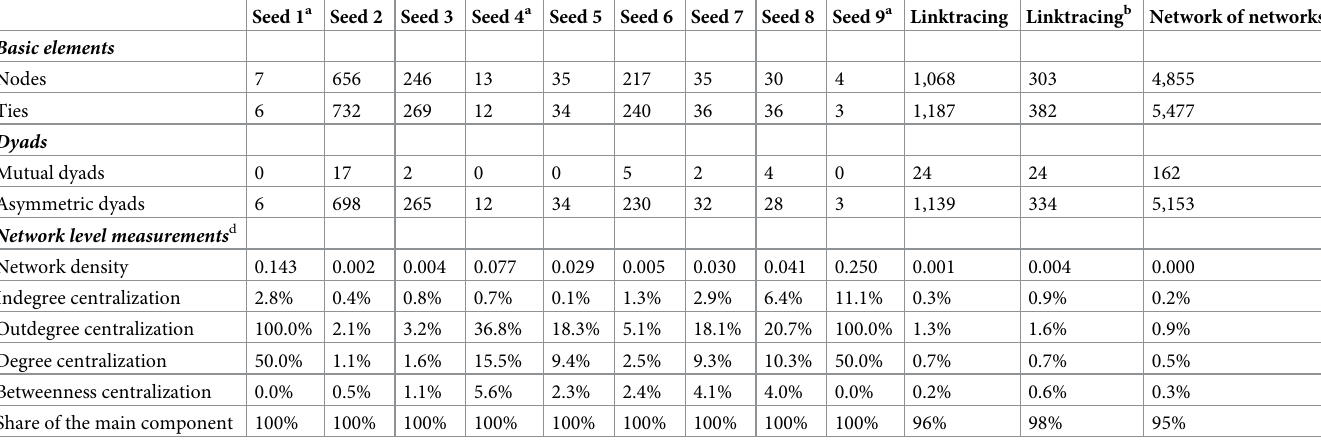
Table 9. Structural characteristics for chain networks, link-tracing network and the network of